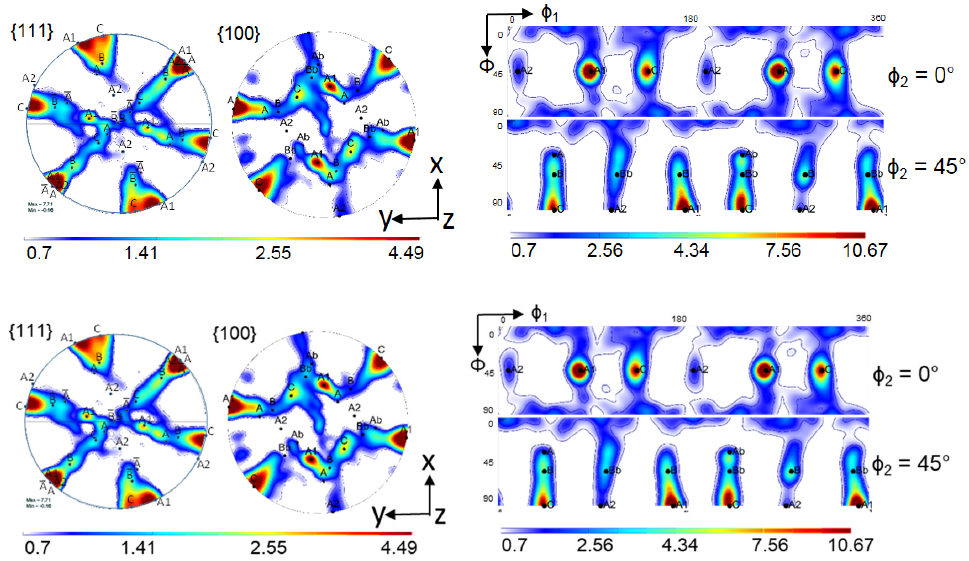
Figure 8. Simulated texture after one-pass ECAP obtained by the Taylor model without twinning in {111} and {100} pole figures as well as in the φ 2 = 0° and 45° ODF sections.